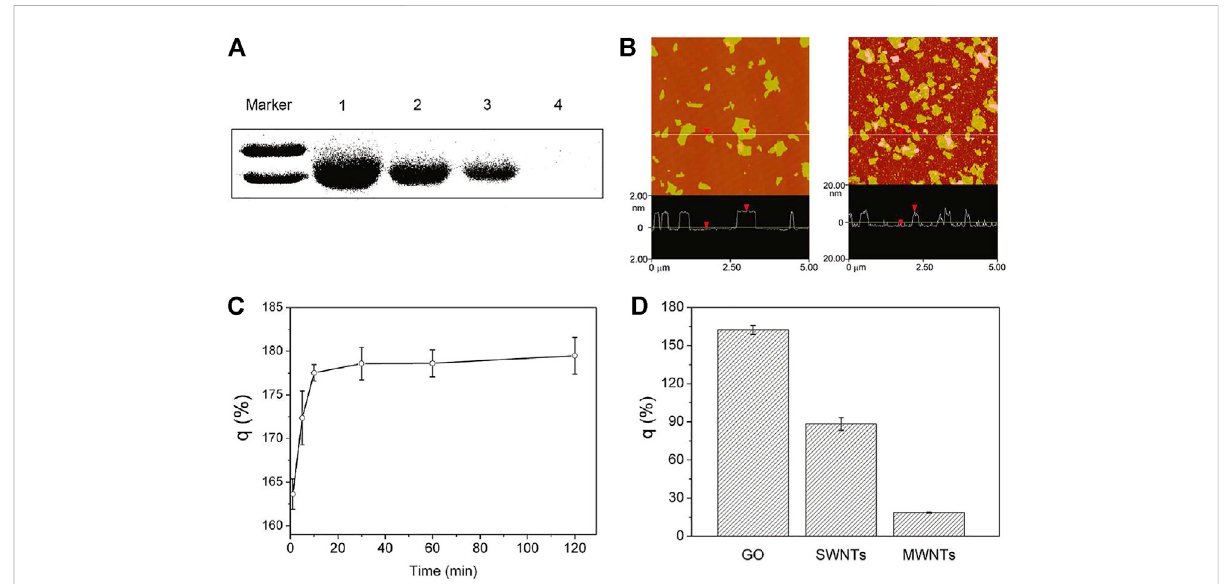
FIGURE 3 CharacterizationofinteractionofGOwithFBSproteins. (A) SDS-PAGEofFBSproteinsinthesupernatantaftercentrifugation. (B) AFMimagesof GO (left) and FBS-coated GO nanosheets (right). (C) FBS protein loading ratio on the surfaces of GO at different incubation times. (D) BSA loading capability of GO, SWCNTs, and